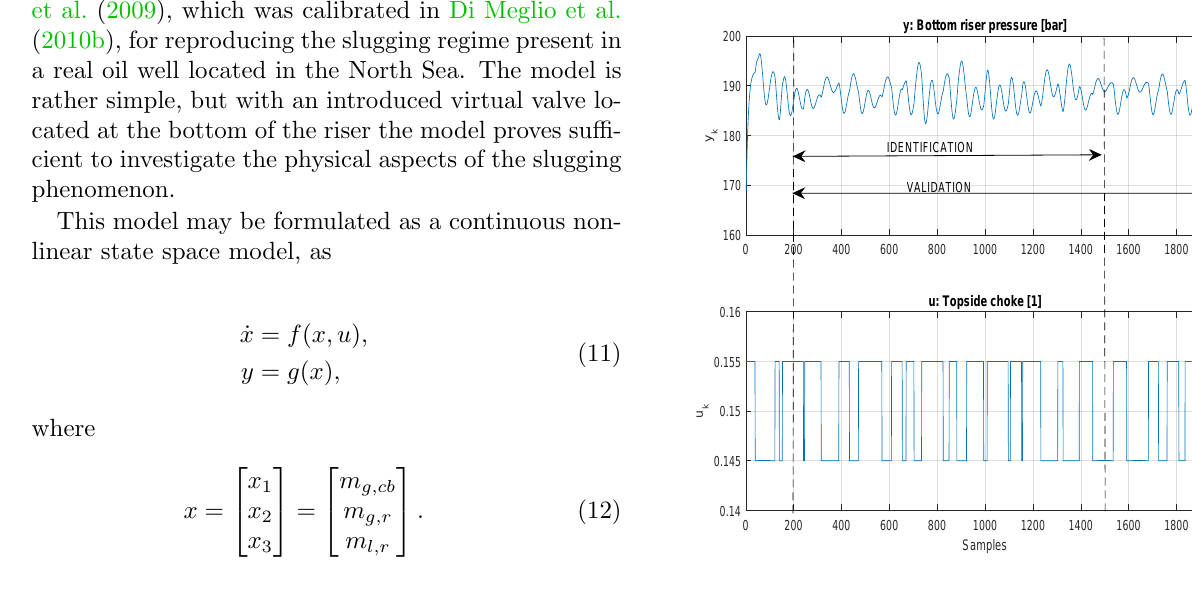
Figure 2: Raw data with length, N = 2000 samples. Identification and validation with lengths, N id = 1301 and N v = 1800. Sam- pling time is 100 sec. @0.15